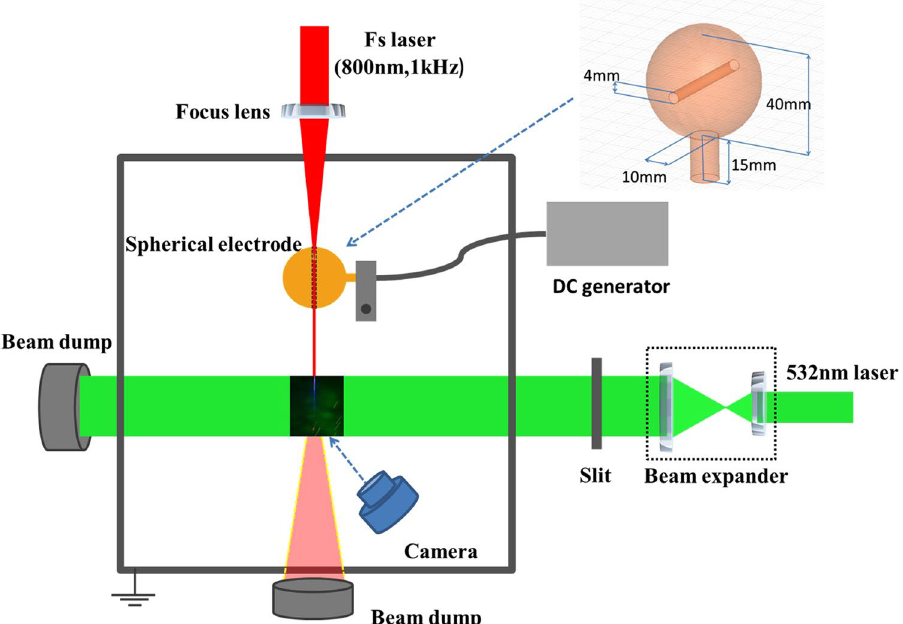
Figure 1. Experimental setup for ionic wind generation by laser guided discharges. The spherical electrode was held with an insulated plastic holder. The electrode design is shown in the inset. A good coupling was achieved by sending laser air plasma channel through the cylindrical channel which was punched through the spherical